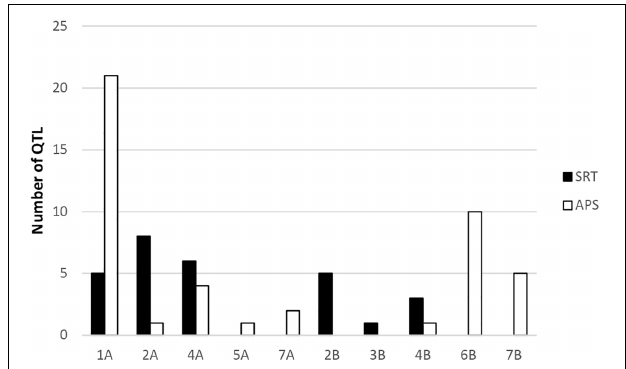
FIGURE 6 | Frequency distribution of QTL at SRT and